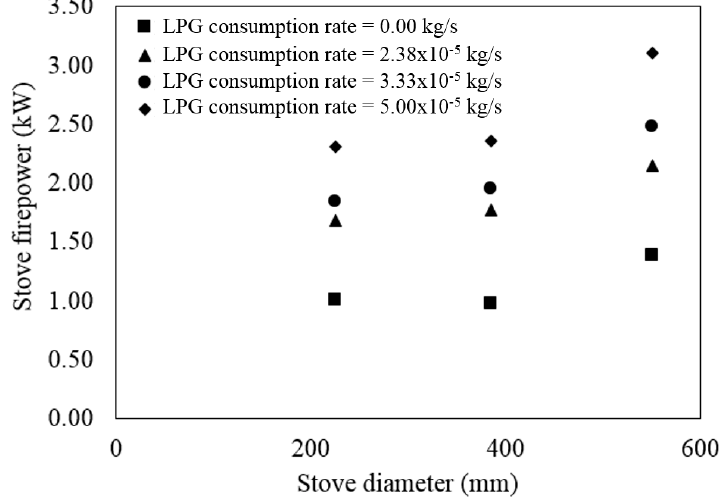
Figure 4. Relationship between firepower and stove diameter.